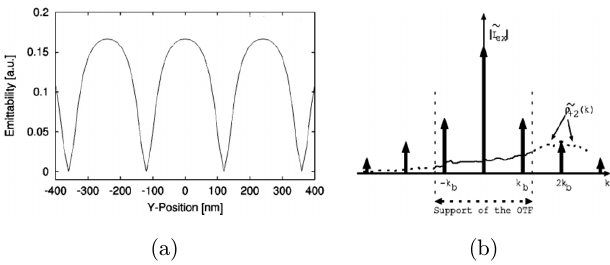
Fig. 3. Fundamental concept of nonlinear SIM implemented by °uorophore saturation. 10 (a) Fluorescence intensity distri- bution in real space with high-intensity illumination leading to °uorophore saturation. (b) Corresponding emittability pattern in Fourier space.